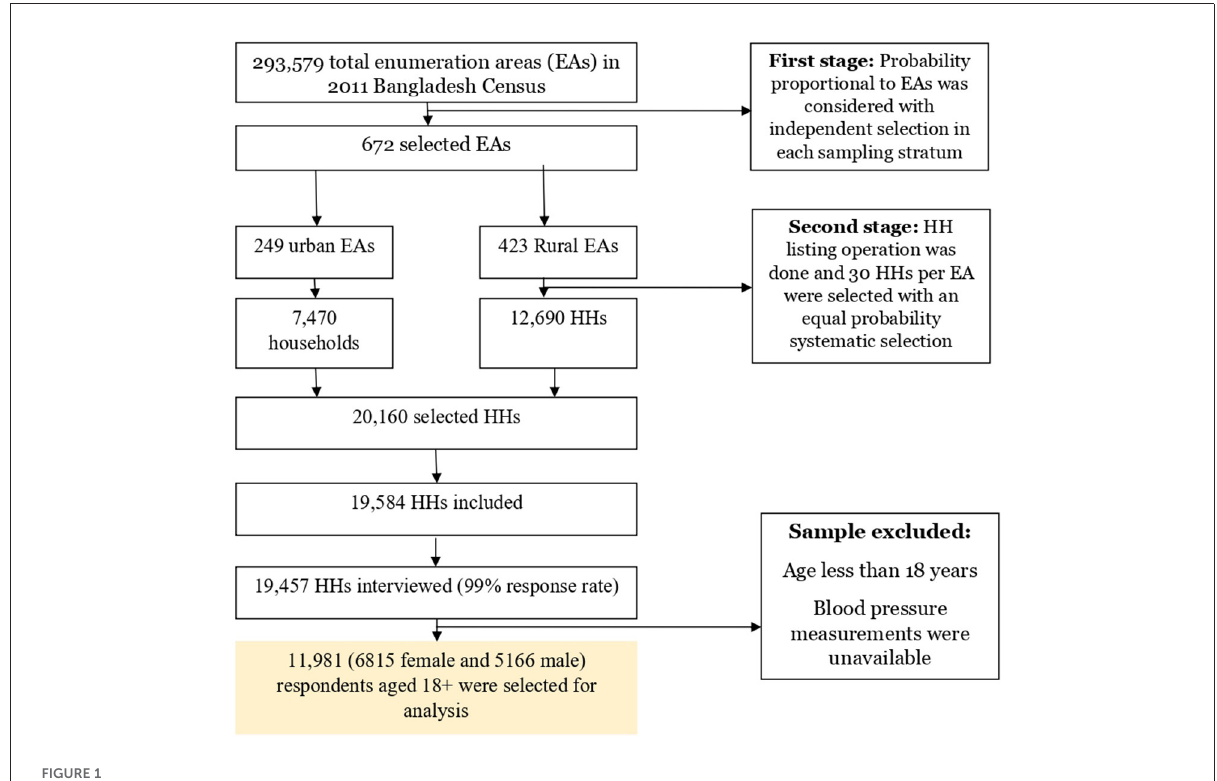
FIGURE1 Flowchart of selecting study